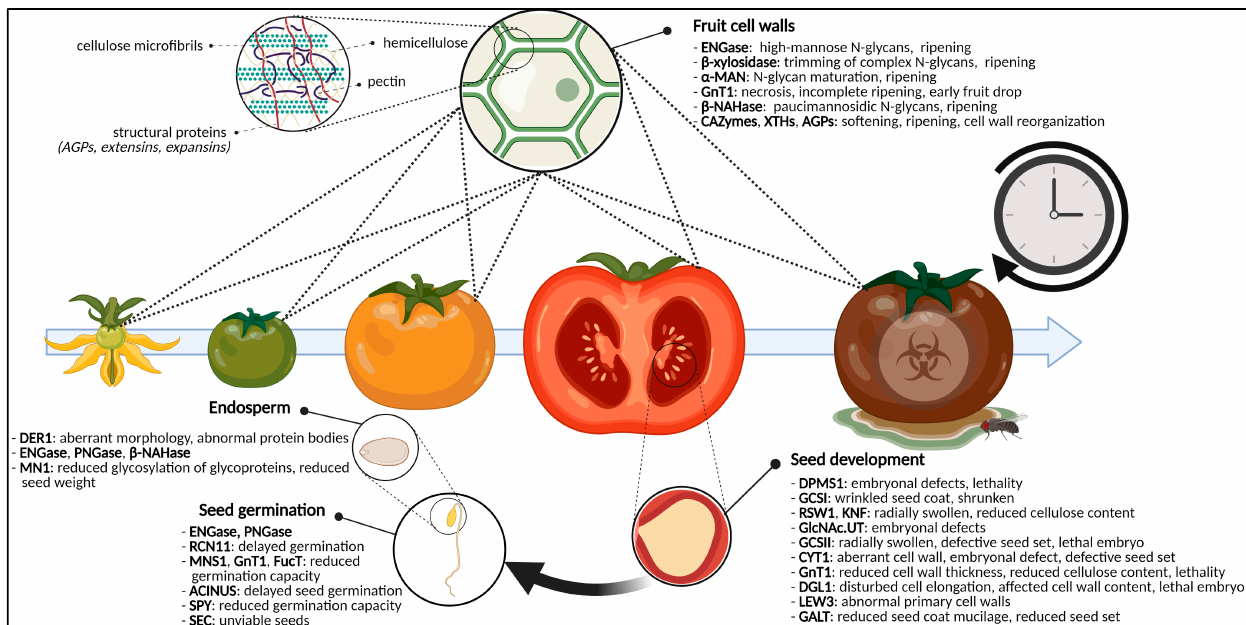
Figure 4. Graphical representation of the glycosylation-related enzymes and their role in fruit ripening and seed development and germination. For fruits, specific glycan-degrading enzymes and CAZymes are important for ripening and softening. Defects in glycosylation enzymes cause aberrant seed morphologies, cell wall shortcomings, embryonal defects, (embryo)lethality and reduced seed set. For the germinating seed, disturbed glycosylation enzymes will postpone germination, reduce germination capacity or will yield unviable seeds. Additionally, the glycosylation state of endosperm glycoproteins will cause certain developmental phenotypes. Abbreviations: ACINUS (Apoptotic Chromatin condensation In- ducer in the Nucleus), AGPs (arabinogalactan proteins), α -MAN ( α -mannosidase), β -NAHase ( β -N-acetylhexosaminidase), CAZymes (carbohydrate-active enzymes), CYT1 (GTP: α -D-mannose-1-phosphate guanylyltransferase), DER1 (DEGRADA- TION IN THE ENDOPLASMIC RETICULUM1), DGL1 (DEFECTIVE IN GLYCOSYLATION1), DPMS1 (dolichol phosphate mannose synthase complex 1), ENGase (endo-N-acetyl- β -D-glucosaminidase), FucT ( α -1,3-fucosyltransferase), GALT (galactosyltransferase), GCSI ( α -glucosidase I), GCSII ( α -glucosidase II), GlcNAc.UT (GlcNAc-phosphate UDP-transferase), GnT1 (N-acetylglucosaminyltransferase I), KNF (KNOPF), LEW3 (Leaf Wilting 3), MN1 (Miniature1), MNS1 (mannosidase I), PNGase (peptide-N4-(N-acetyl- β -D-glucosaminyl) asparagine amidase), RCN11 (Reduced Culm Number 11), RSW1 (RADIALLY SWOLLEN1), SEC (SECRET AGENT), SPY (SPINDLY), XTH (xyloglucan endotransglycosylase/hydrolase). This figure was created with